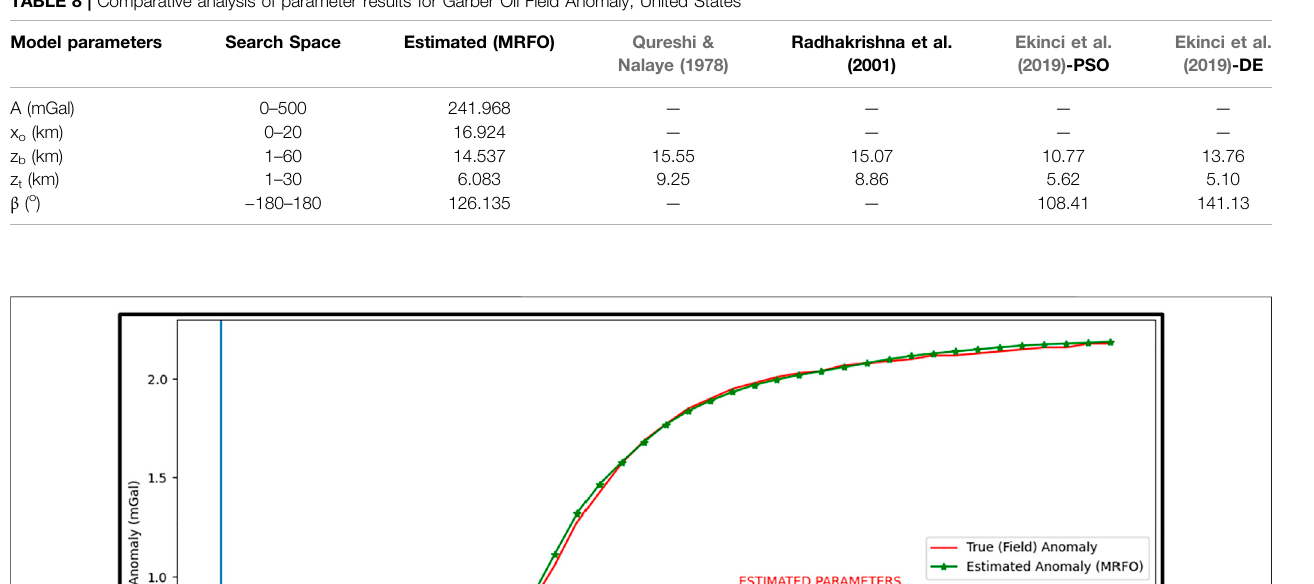
Frontiers in Earth Science |